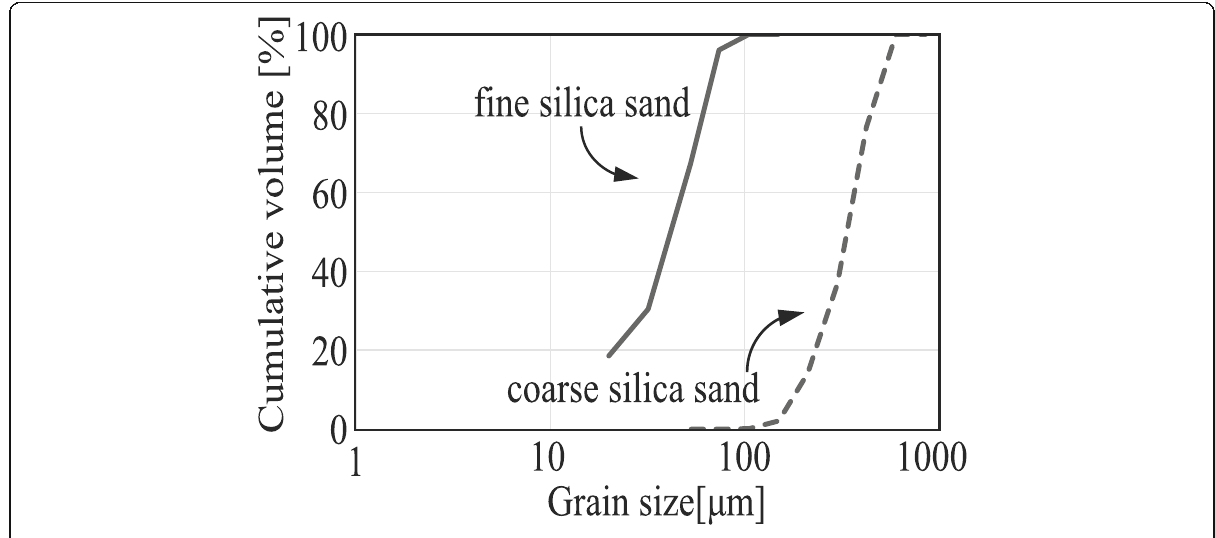
Fig. 2 Grain size accumulation curve for fine and coarse silica